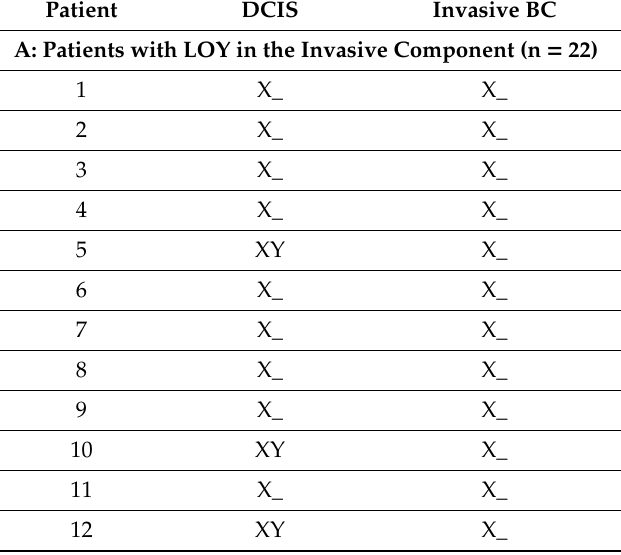
Table 3. Whole slide LOY analysis of patients with invasive BC and adjacent ductal carcinoma in situ